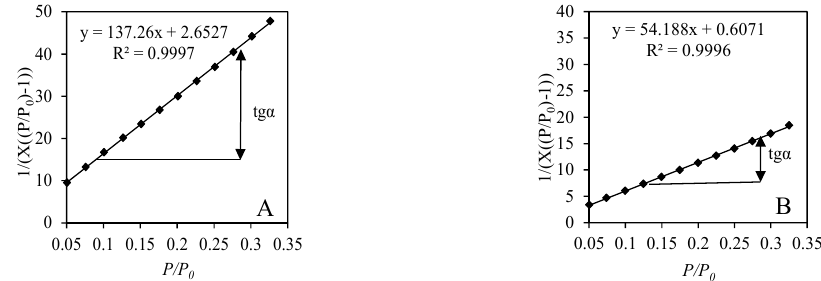
Figure 8. Isotherm of N 2 adsorption at 77 K in BET plot of products after 12-h synthesis from mixtures: lime–GSW ( A ), lime–calcined opoka ( B ).